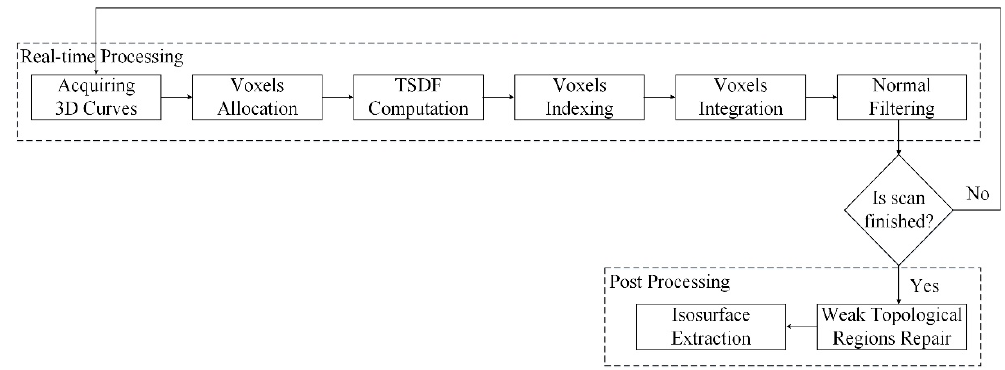
Figure 5. Pipeline of the proposed surface reconstruction method based on 3D curves.